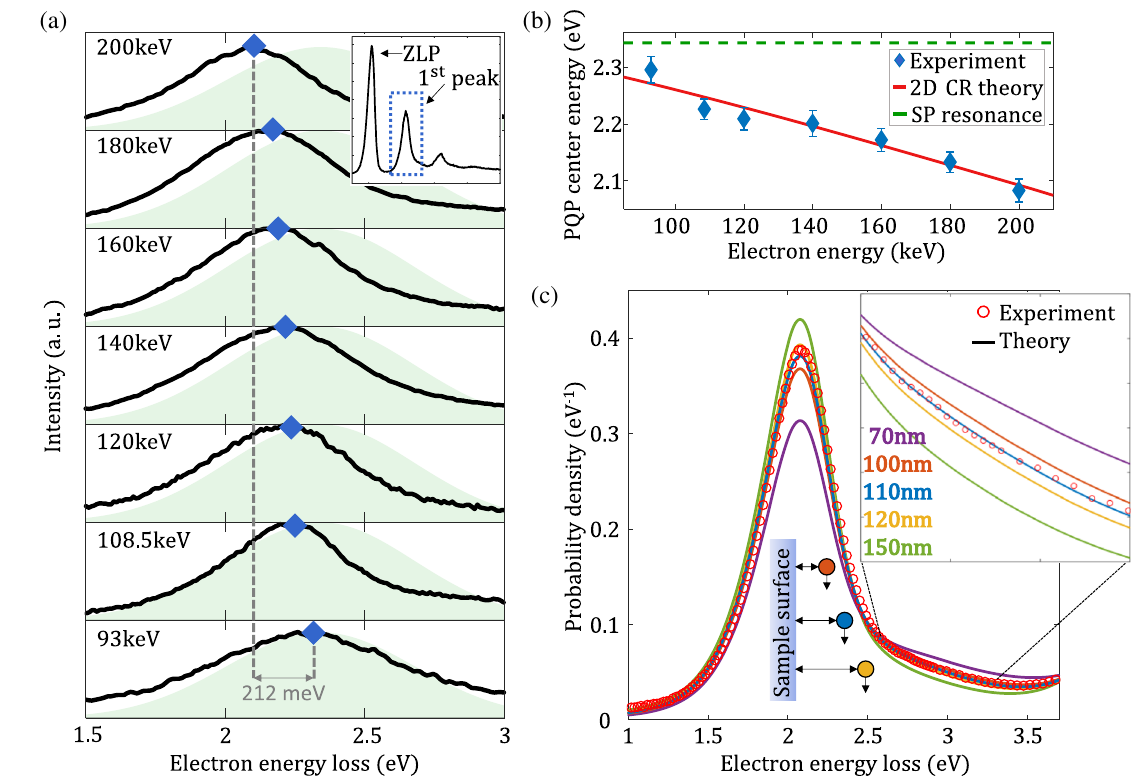
FIG. 3. First observation of 2D CR: satisfying the Cherenkov extended phase-matching condition. (a) The first EELS peak of each measurement (solid black line) for electrons grazing the multilayer structure. Increasing the electron energy results in a redshift of the peak, a signature of 2D CR. The shifting peak stands in contrast to EELS of common nonpropagating surface plasmon resonances, which remain constant when changing the electron energy (light green). The inset presents a characteristic raw measurement. (b) Comparison of experiment and theory. The measured peak energies from (a) (blue diamonds) are compared to theory of 2D CR into PQPs (red; see calculation in Supplemental Material, Note 1 [64]) and to the excitation of nonpropagating surface plasmon (SP) mode (dashed green line). Only the former shows agreement with our measurements. (c) Analysis of the EELS peak shape of 2D CR: comparison of theory and experiment. The first EELS peak is shown for a range of impact parameters, exhibiting the hallmark asymmetrical profile of the 2D CR emission spectrum, similar to Fig. 1(e). The spectrum has its peak at the Cherenkov threshold, a feature of 2D CR that differs substantially from the case of 3D CR. The good match of the simulated peak shape and location (colored solid lines) with the measured data (red circles) provides additional evidence for our observation of 2D CR and allows extraction of the effective impact parameter of the electron beam centroid with 10 nm accuracy. The inset shows an enlargement, which provides a more precise estimate of small changes in the impact parameter. The upward slope at the right edge of the spectrum arises from the second EELS